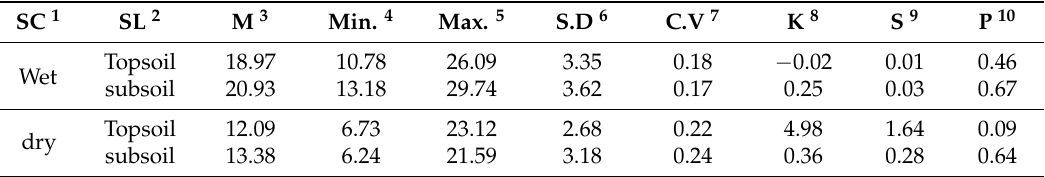
Table 2. Descriptive statistics and Kolmogorov-Smirnov test for average soil moisture for wet and dry conditions.